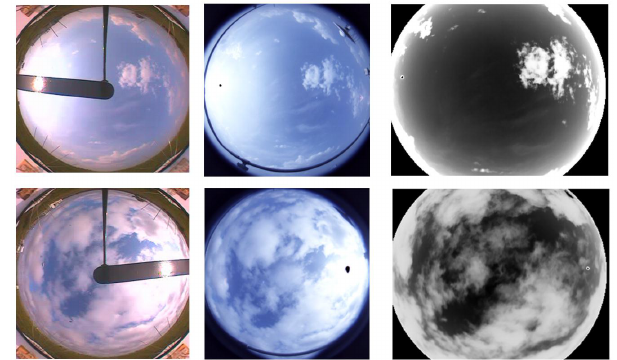
Figure 2. All-sky images acquired on May 25, 2009 at 23:07 UTC (top) and July 21, 2009 at 2 Fig. 2. All-sky images acquired on 25 May 2009 at 23:07UTC (top) 14:17 UTC (bottom). Images shown are from the TSI instrument (left), the ASIVA Visible 3 and 21 July 2009 at 14:17UTC (bottom). Images shown are from camera (middle), and from ASIVA’s 10.2-12.2 µm IR channel (right). 4 the TSI instrument (left), the ASIVA visible camera (middle), and from ASIVA’s 10.2–12.2µm IR channel